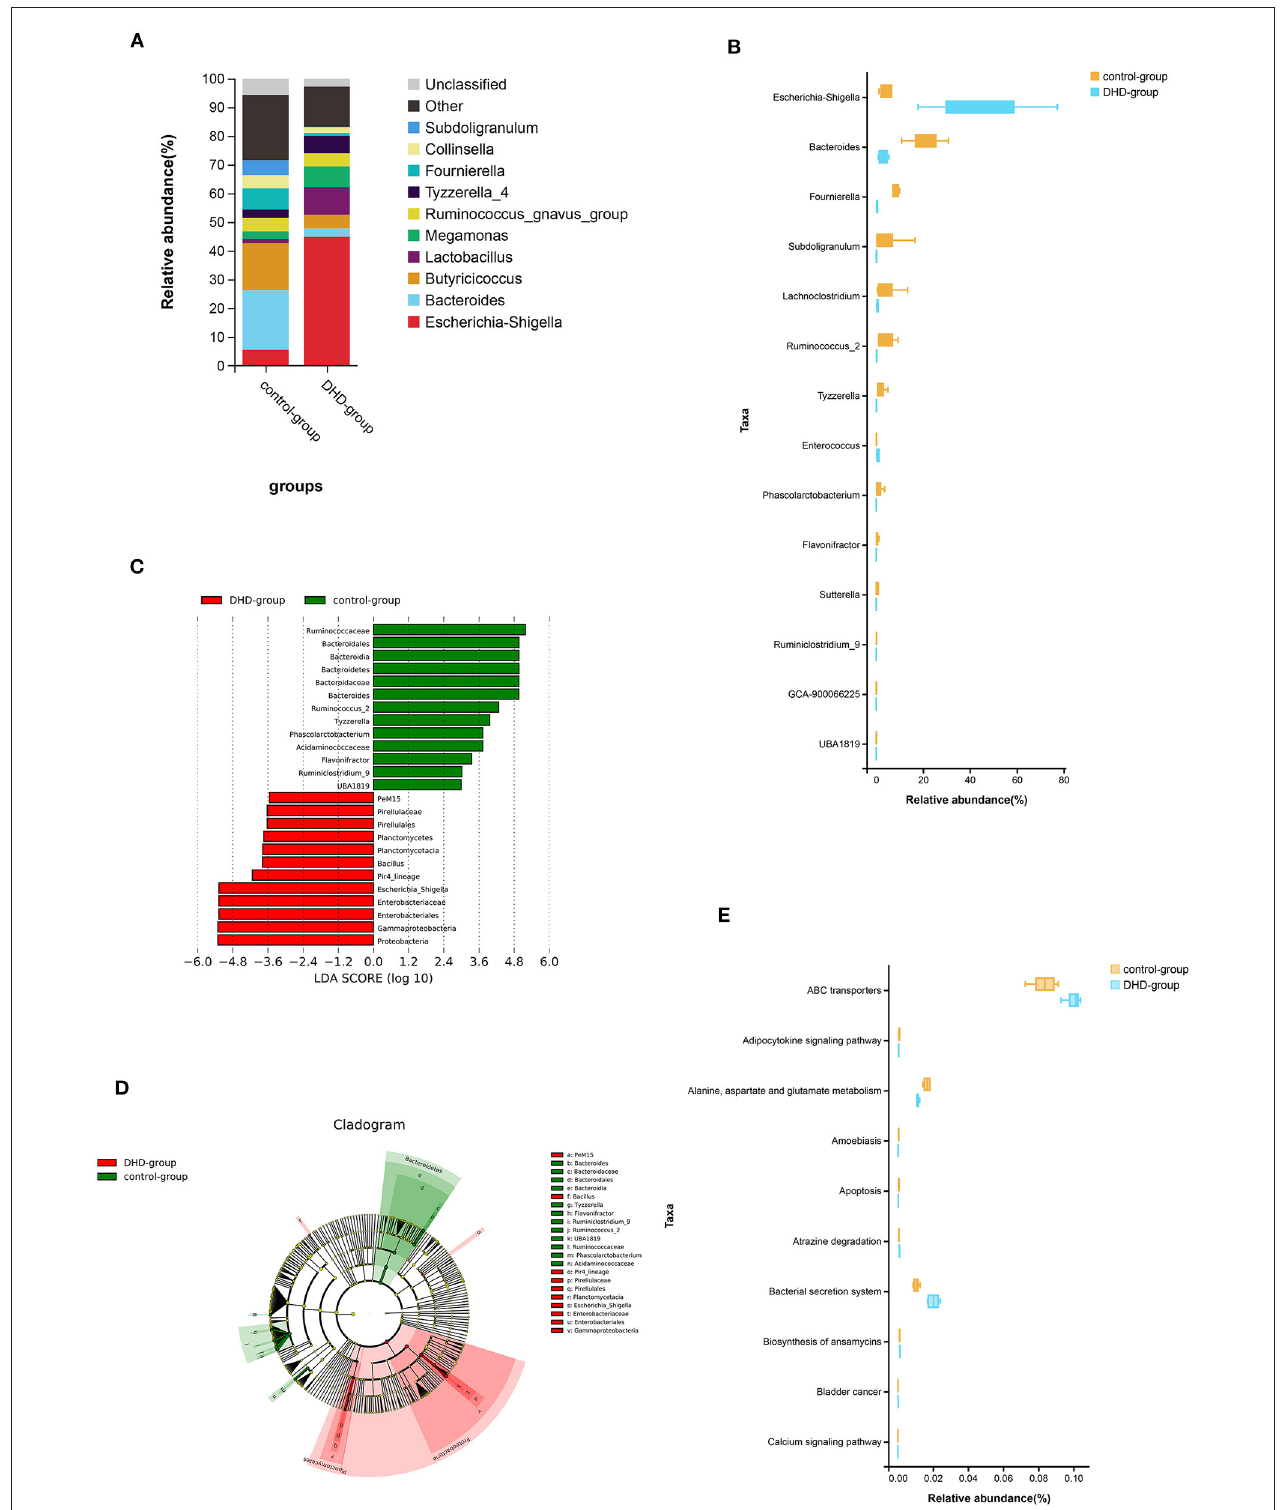
FIGURE 2 | Fecal microbial abundance and diversity in DHD calves and healthy calves. (A) Taxonomic distributions of bacteria at the genus level (top 10) between DHD and healthy calves. (B) Box plot of the generic bacteria with significantly different between these two groups. Data for each group are shown as